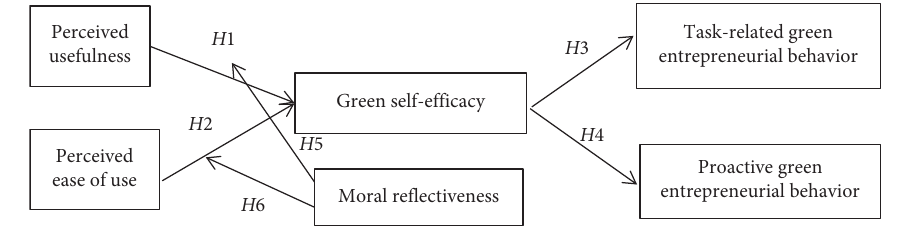
Figure 1: The concept